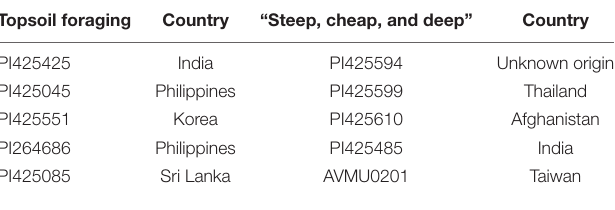
TABLE 3 | Top five genotypes by iRoot rank categories from day 15 image analysis. Topsoil